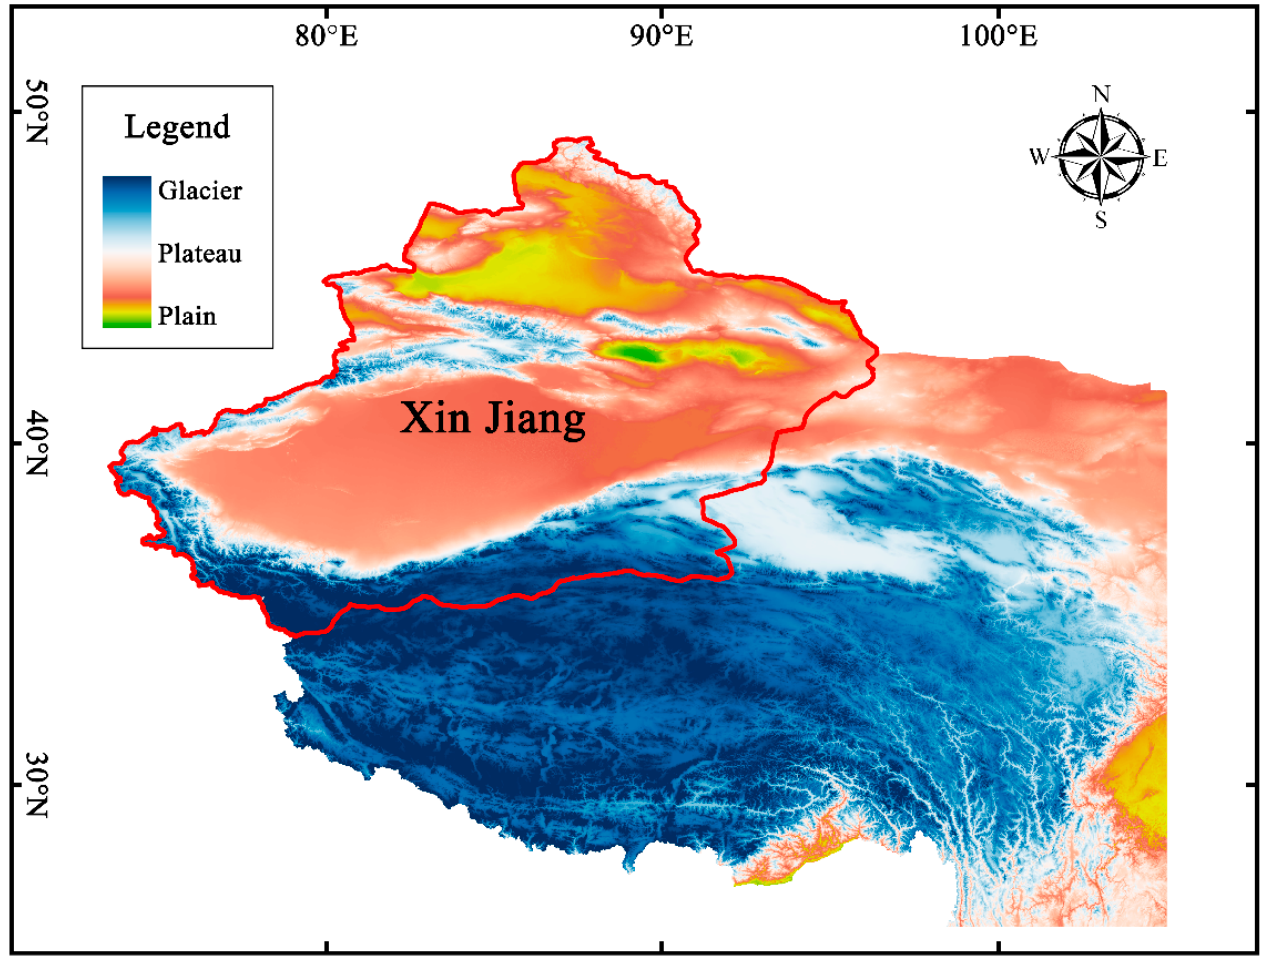
Figure 1. Distribution of the glaciers in Northwest China.